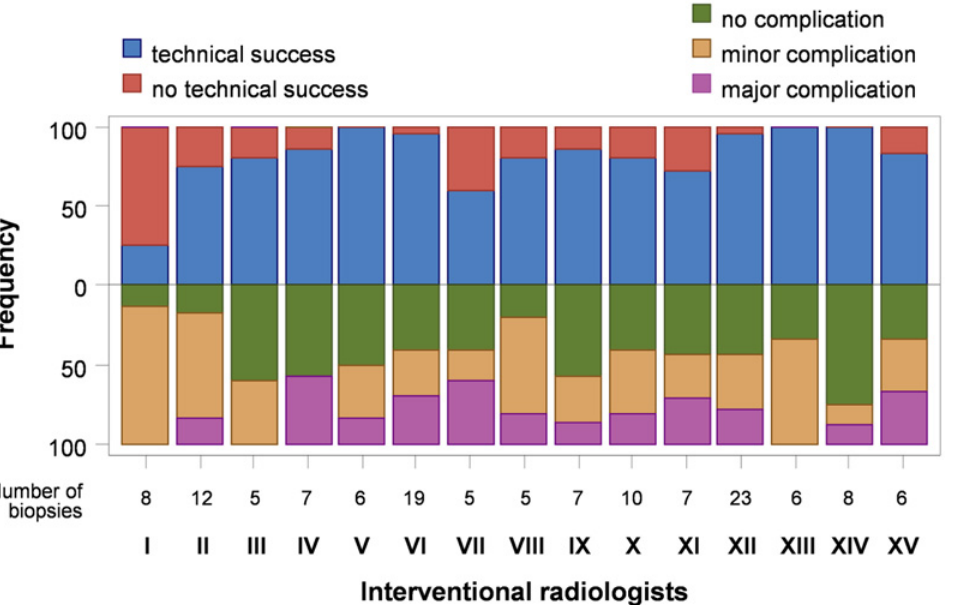
Fig 4. Technical success (upper part) and rate of complications (lower part) by interventional radiologists. There was a significant difference in technical success between interventional radiologists, suggesting that interventional radiologists-related factors strongly affect outcome of percutaneous transthoracic biopsies of pulmonary